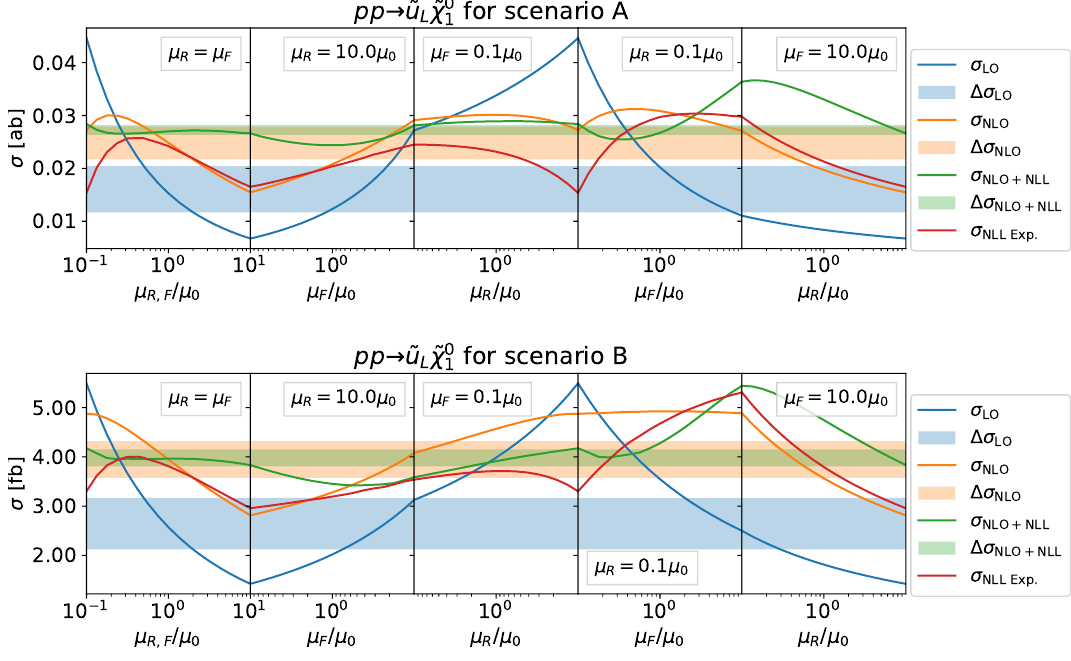
Figure 5. Profiles of the renormalisation and factorisation scale dependence of the total cross section corresponding to the process pp → ˜ u L ˜ χ 0 in scenarios A and B. The plots cover µ F,R ∈ (0 . 1 − 10) µ 0 1 (reversely in panels 2 and 3) with a central scale µ 0 = ( m ˜ q + m ˜ χ ) / 2 . The bands correspond to scale √ uncertainties evaluated with the seven-point method, and we use S = 13 TeV and MSHT20 PDFs. We present predictions at LO, NLO and NLO+NLL, as well as for the O ( α 2 ) expansion of the s NLL